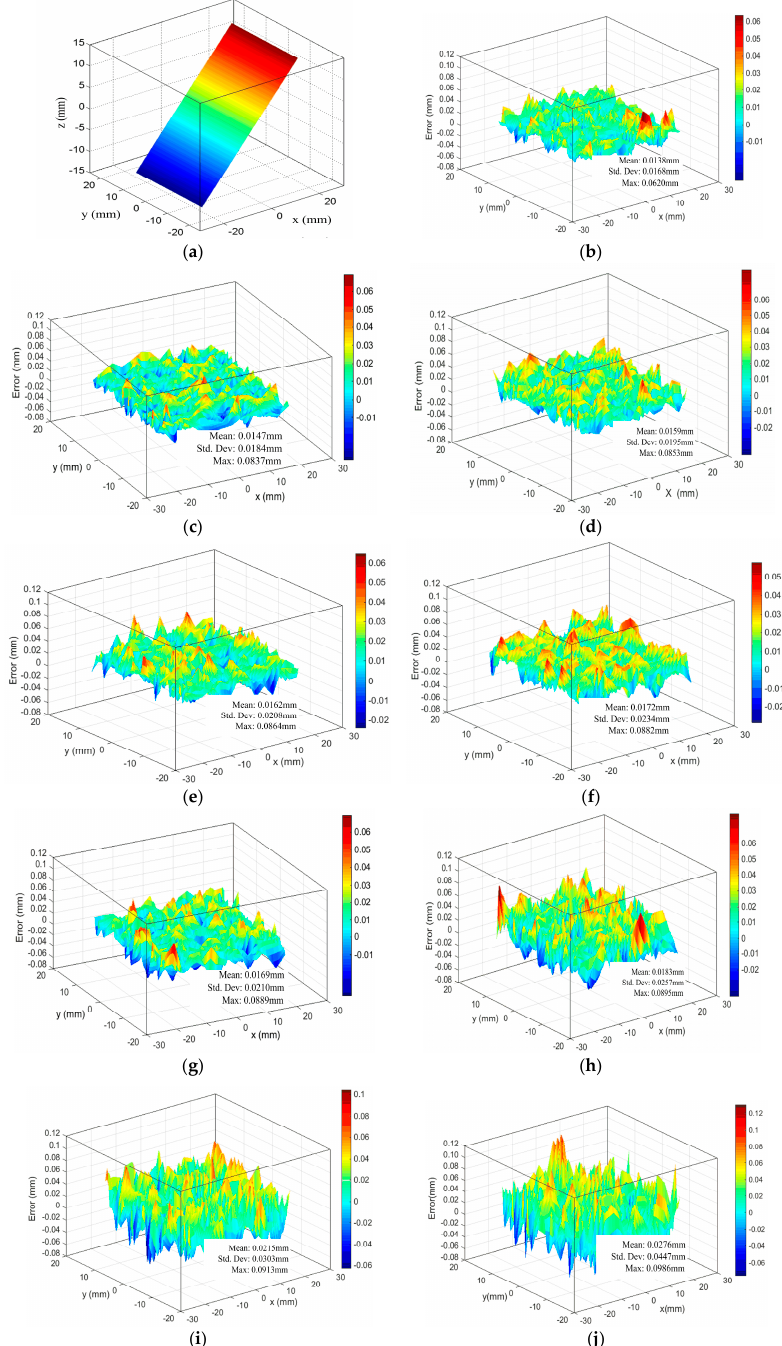
Figure 17. Measurement results and error of plane under different defocusing degrees: ( a ) fitting plane; ( b ) measurement error of the plane under defocusing degree 1 (projector in focus); ( c – f ) measurement error of the plane under defocusing degree 2–5 by our proposed calibration method; ( g – j ) corresponding the measurement error of the plane under defocusing degree 2–5 by the calibration method in [29]. Table 5. Statistics of the measurement results of plane (unit: mm).